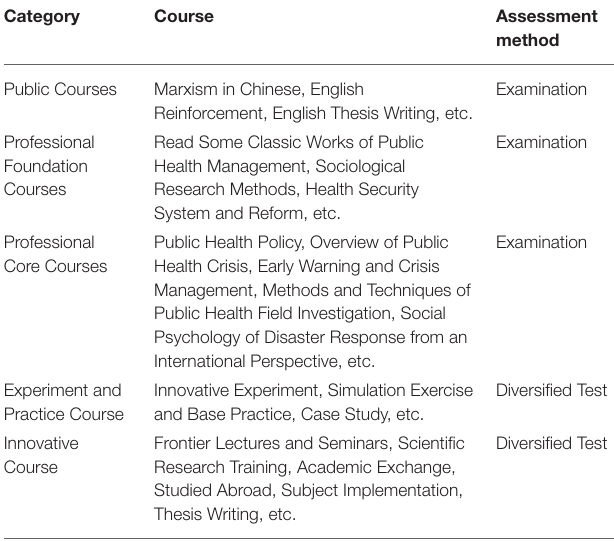
TABLE 1 | Curriculum system of